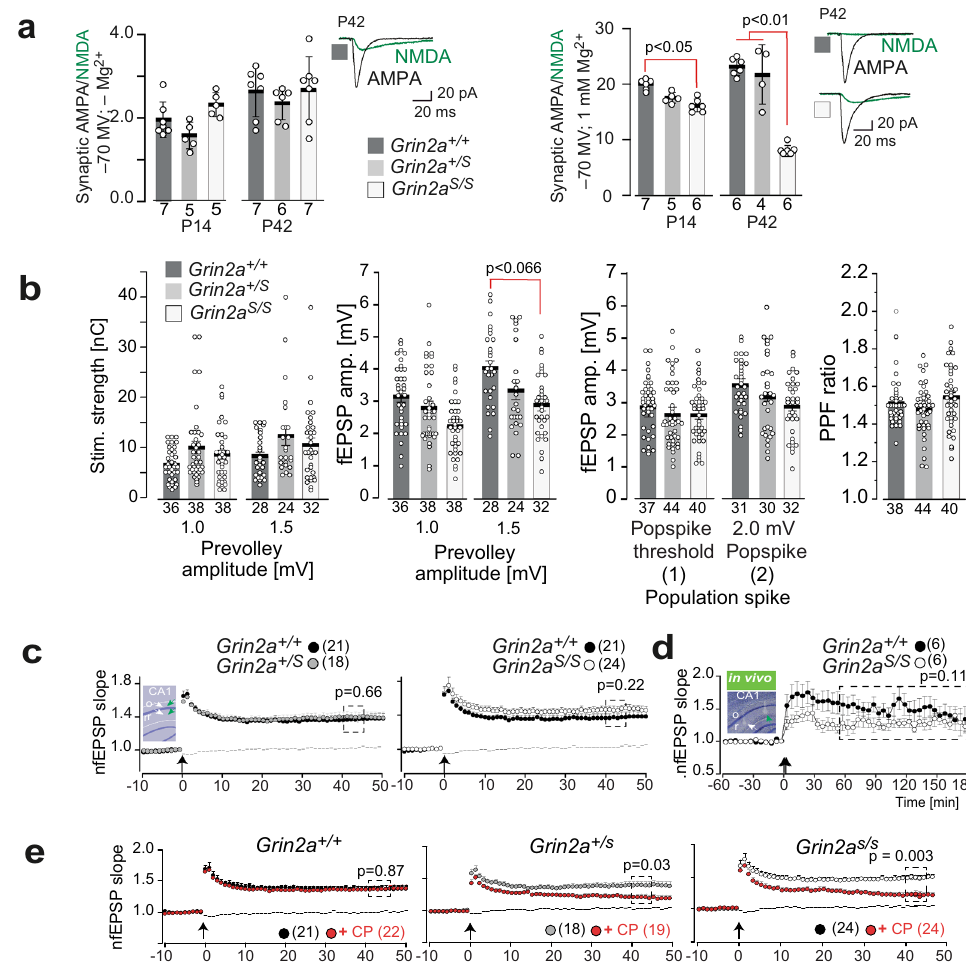
Fig. 2 Hippocampal synaptic transmission and plasticity in Grin2a S/S and Grin2a + /S mice with the GluN2A(N615S) mutation. a (left) In the absence of extracellular Mg 2 + the synaptic AMPA/NMDA ratio of CA1 pyramidal cells in acute hippocampal slices is not altered in Grin2a + /S and Grin2a S/S mice compared to control littermates. (right) In the presence of extracellular Mg 2 + the strong reduction of the AMPA/NMDA ratio in Grin2a S/S mice relates to the increased NMDA currents at CA1 synapses (Tukey ’ s test). Example traces are depicted to the right of each bar graph. Data from the same experimental group were pooled across animals and are presented as mean ± SEM (see also ref. 35 ) with p < 0.05 being designated as statistically signi fi cant. Numbers in bar graphs indicate the number of slices. b Paired-pulse facilitation at CA3-to-CA1 synapses excluded strong alterations of presynaptic function in mutant mice. The stimulation strengths (in nC) necessary to elicit a pre-volley of 1.0 and 1.5 mV and the resulting fEPSP amplitudes were comparable in all genotypes but showed only a trend towards lower fEPSP amplitudes recorded at 1.5 mV pre-volley amplitudes in Grin2a S/S mice. The fEPSP amplitudes necessary to elicit a just detectable population spike (1) and a population spike of 2 mV amplitude (2) and the paired-pulse facilitation ratio (PPF) at an interstimulus interval of 50 ms did not indicate any synaptic impairments in Grin2a S/S and Grin2a + /S mice compared to WT littermates. The number of slices is indicated in the bar graphs or in brackets. c Field LTP (fLTP) at CA3-to-CA1 synapses, induced by tetanic stimulation in slices (1 s; 100 Hz; arrow), was comparable in all three genotypes. The inset in c gives a schematic view of the stimulating (white arrow) and the recording (green arrow) electrode positions in s tr. radiatum (r) and str. oriens (o). d Similarly, CA1-to-CA3 fLTP (induction: 2 × 1 s; 100 Hz; arrow) in freely moving mice was comparable between Grin2a S/S and Grin2a + / + mice. The inset shows a Nissl-stained slice of one recorded mouse post mortem. e In mutant mice, but not in control littermates, the GluN2B-containing NMDAR contributes signi fi cantly to the magnitude of LTP, since LTP was signi fi cantly reduced by the GluN2B- speci fi c antagonist CP101,106 (CP). Recordings of the non-tetanized control pathway in c and e are given as dashed lines. Error bars represent mean ± SEM (for statistics: Supplementary Statistics to Fig. 2).